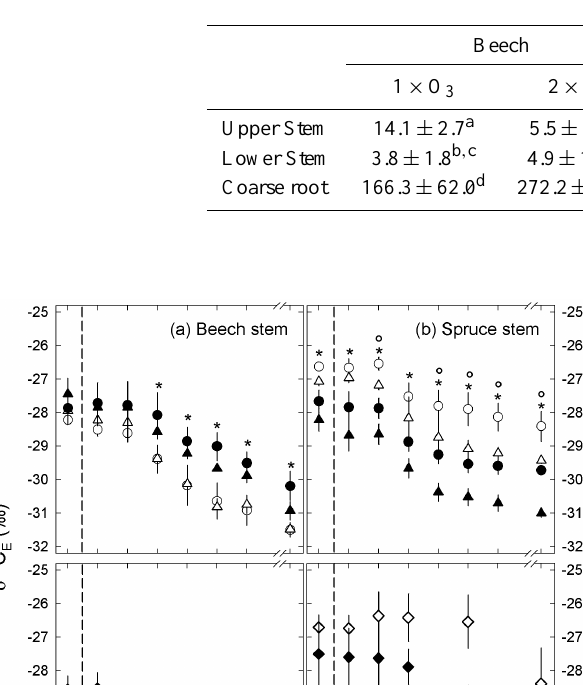
Table 3. Stem and coarse root CO 2 efflux (µmolm − 3 s − 1 ) of beech and spruce during the 2.5 weeks of labeling. Data are shown as means ± SE ( n = 3 trees). Within one species, lowercase letters denote significant differences among upper and lower stems ( a , b ) and lower stems and coarse roots ( c , d ) , respectively ( p ≤ 0 . 05). Asterisks denote significant differences between O 3 regimes ( p ≤ 0 . 05). Statistical evaluation was performed using the t-test for paired comparisons.